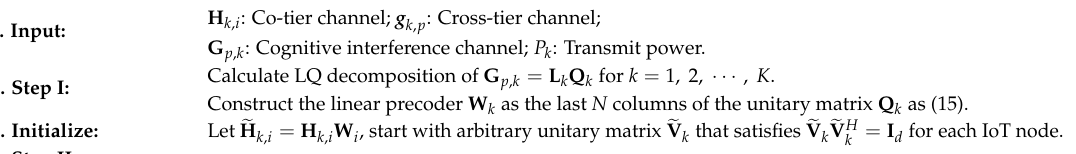
Algorithm 1 Interference nulling based cognitive interference alignment (IN-CIA) ( H k , i , G p , k , g k , p , P k